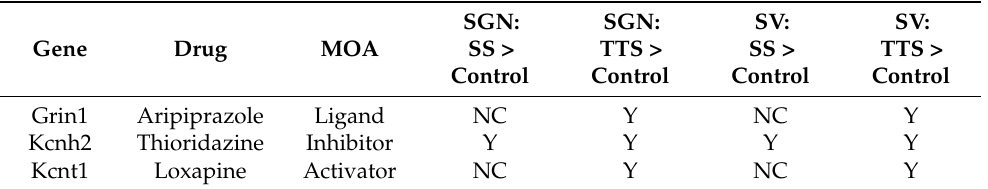
Table 2. FDA approved, orally administered antipsychotics that interact with steroid-responsive genes in the cochlea localized to SGN and SV cell types.